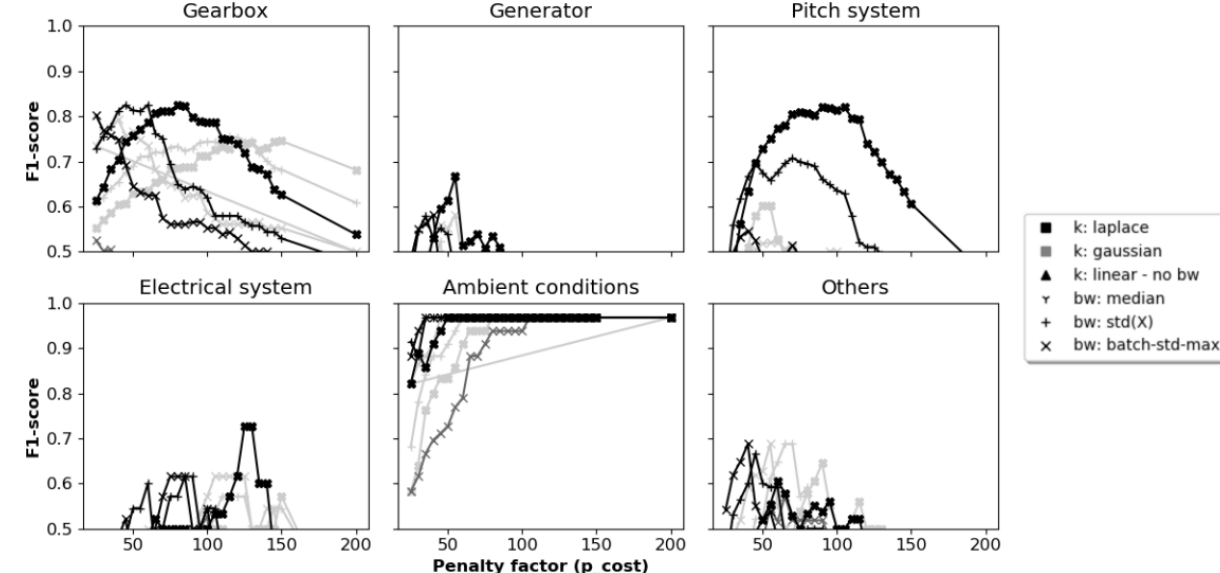
Figure C2. The 1-year signal validation: F1 scores per component for different hyperparameter configurations and penalty